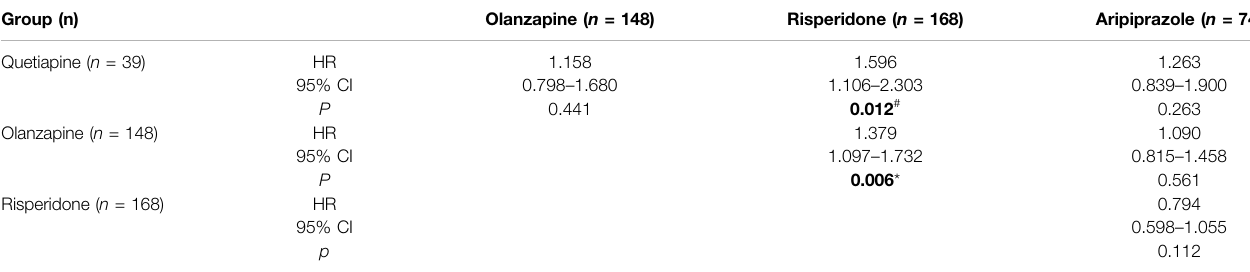
TABLE 5 | Cox regression analysis of TTD in four groups of monotherapy. Group (n) Olanzapine ( n = 148) Quetiapine ( n = 39)